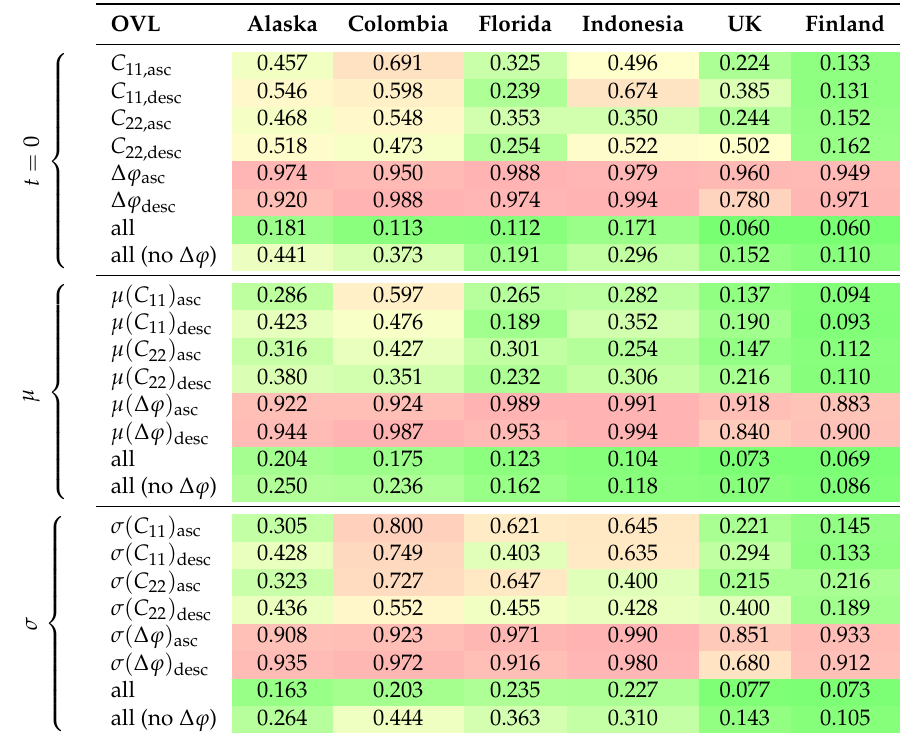
Table 1. This table shows the overlap coefficients between the forest and non-forest distributions for a variety of different variables including C 11 (VV backscatter), C 22 (VH backscatter), and the phase difference ∆ ϕ , each for ascending and descending orbit, as well as combinations thereof. The three horizontal sections show the results for a single image ( t = 0), as well as the mean ( µ ) and the standard deviation ( σ ). A value close to 0 means low overlap and high separability, whereas a value close to 1 means large overlap and low separability. The table is color coded on a linear scale; with green, yellow, and red corresponding to overlap coefficients of 0, 0.5, and 1,